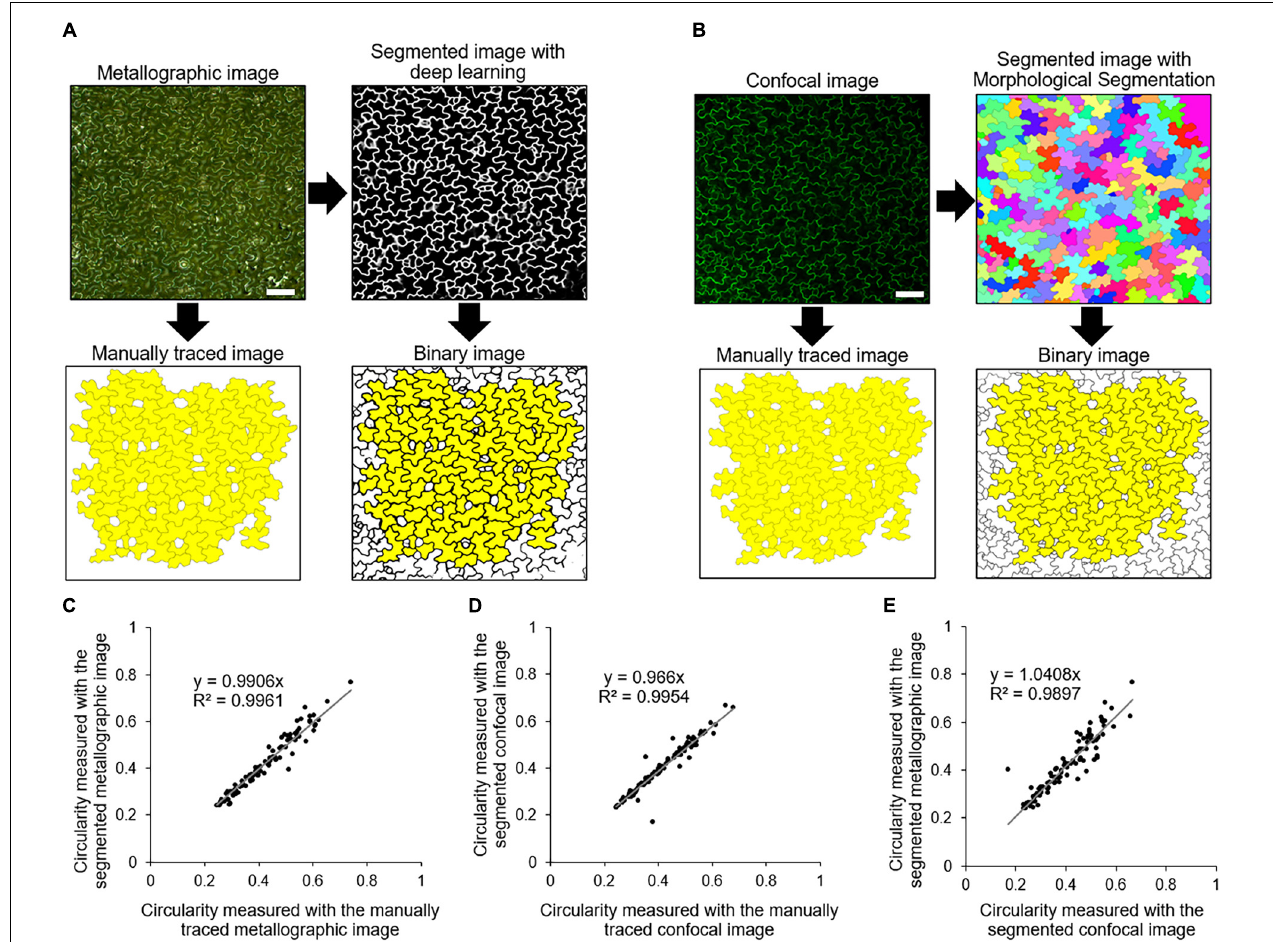
FIGURE 3 | Cell segmentation and validation. (A) Manual tracing and segmentation based on deep learning of a metallographic image of a silver ink-coated A. thaliana cotyledon. Yellow indicates the cells that were used for measurements of cell circularity. N = 100. Scale bar indicates 100 µ m. (B) Manual tracing and segmentation using Morphological Segmentation (Legland et al., 2016) of confocal images of a plasma membrane marker GFP-PIP2a. Yellow indicates the cells that were identical to those highlighted in yellow in (A) . Scale bar indicates 100 µ m. (C,D) Scatter plots of the circularity of the cells highlighted in yellow in (A,B) , respectively. The relationships between the values measured with the manually traced images and the segmented images are shown. (E) Scatter plot of the circularity of the cells highlighted in yellow in the binary image in (A,B)